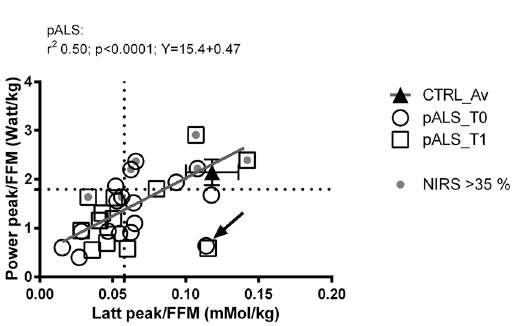
Figure 2. Correlation between peak blood lactate concentration [La] and peak power at exhaustion, normalized for metabolic mass (fatty free mass, FFM), in pALS and CTRL. Four quadrants were defined by drawing dotted lines, according to one SD below the average for CTRL for both variables. White circles: pALS at baseline (T0); white squares: pALS after 4 months (T1); grey triangles: matched healthy CTRL; grey dot: pALS with vastus lateralis O 2 extraction > 35%. Black arrow indicates 1 patient with atypical